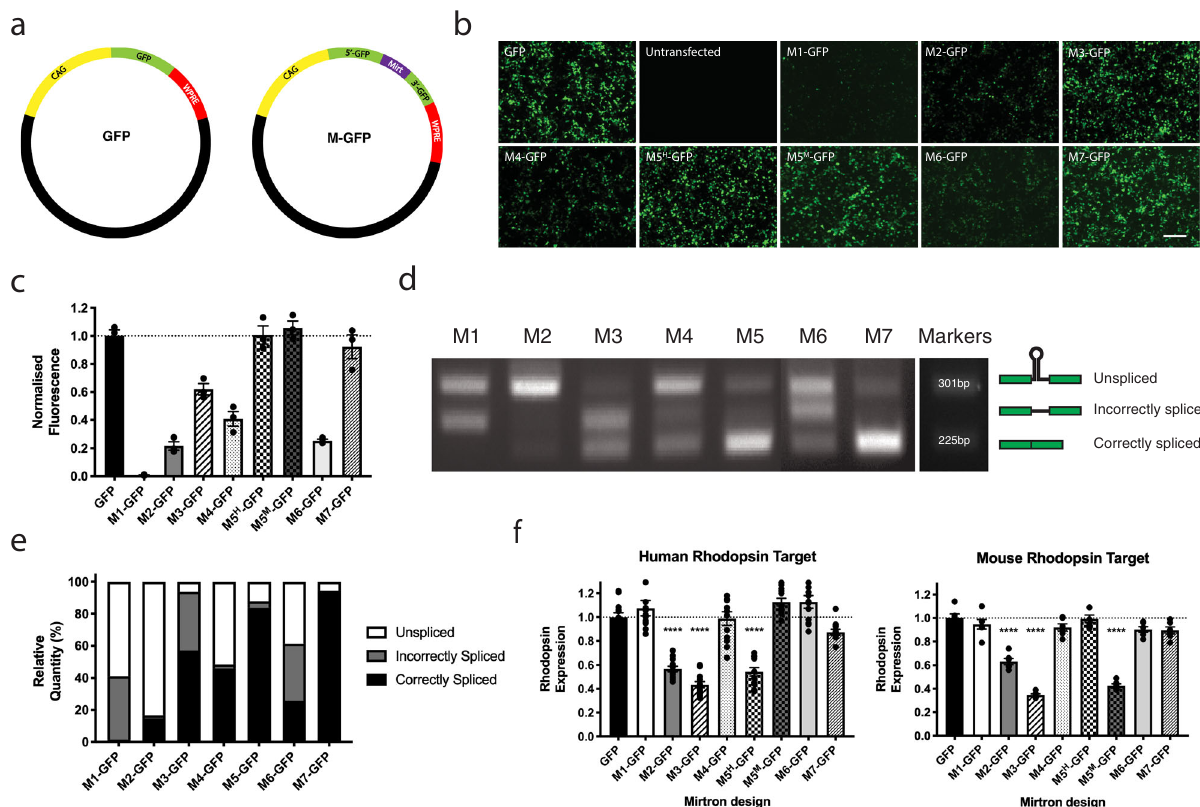
Fig. 1 Splicing ef fi ciency and in vitro potency of candidate mirtron designs. a GFP and Mirtron-GFP plasmid maps. The 76bp mirtron is nested within the eGFP CDS dividing it into 5 ′ and 3 ′ fragments. b Fluorescence micrographs of HEK293 cells taken 48h post-transfection with GFP and M-GFP plasmids using identical acquisition settings. Scale bar = 200 µ m. Experiment repeated three times. c Fluorescence levels (mean±SEM) of protein lysates from M-GFP transfected HEK293 samples normalised to that of the GFP-transfected control group ( n = 3 each). d Representative UV agarose gel image of splice PCR products. The schematic to the right indicates the predicted origin of bands detected. Experiment repeated three times. e Relative densitometry of bands corresponding to PCR products derived from a mirtron-spanning primer pair (shown in d ). Note that proportions of correctly spliced product as determined by this method (black bars) broadly re fl ect corresponding estimates of splicing ef fi ciency derived from the fl uorescence assay (shown in c ). f Determination of mirtron-mediated rhodopsin suppression for human ( n = 12) and mouse ( n = 6) rhodopsin targets by the Dual Glo ® luciferase assay (Promega, UK). Mean± SEM is plotted in all cases. Note that each version of M5 was only effective at targeting the rhodopsin sequence of its corresponding species. Ordinary one-way ANOVA for effect of mirtron type on relative luciferase ratio for human target F (8, 99) = 41.9, p <0.0001; and for mouse target F (8, 45) = 77.88, p <0.0001; **** p <0.0001 versus the mirtronless CAG.eGFP.WPRE plasmid, Dunnett ’ s multiple comparisons